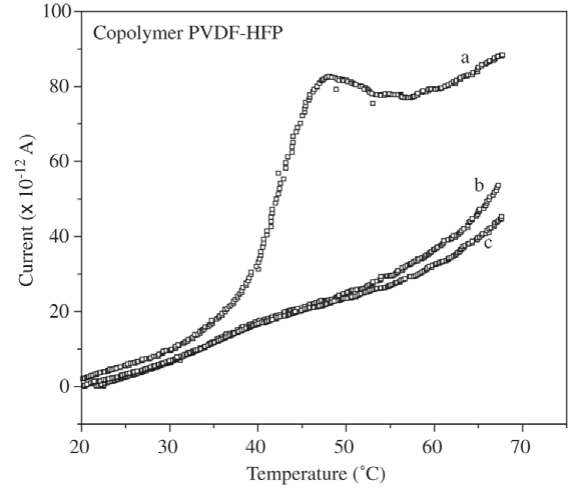
Figure 4. Typical thermally stimulated discharge current and pyroelectric current for the 50/50 vol.% PZT/PVDF-HFP com- posite: a) first run; b) second run; c) third